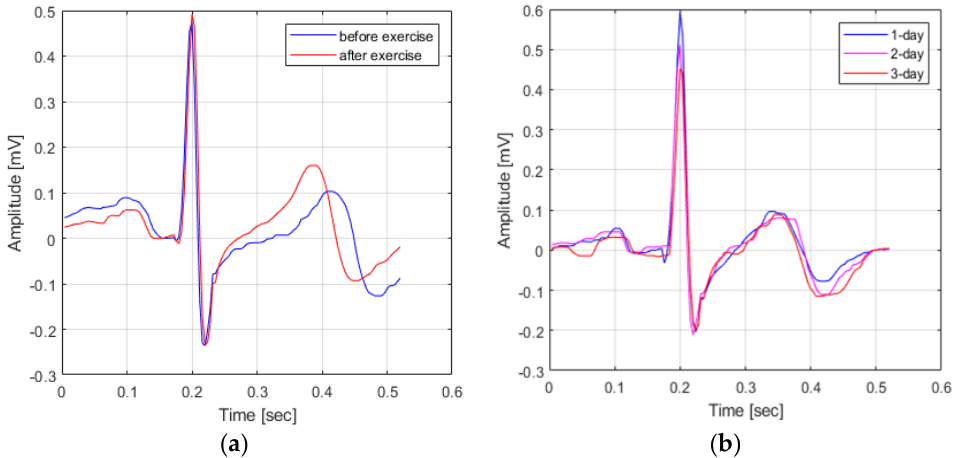
Figure 1. Variation in ECG signals based on waveform changes. ( a ) Variation in ECG signals based on a change in user state ( a ) and Variation in ECG signals change in time ( b ).